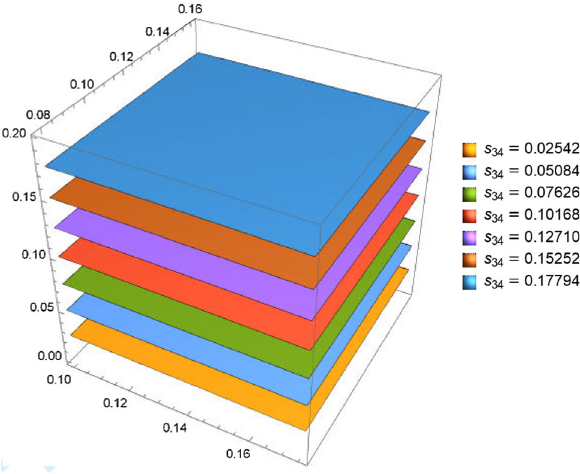
Fig. 4 | g u | versus s 14 and s 24 with s 14 ∈ ( 0 . 099 , 0 . 176 ) and s 24 ∈ ( 0 . 0782 , 0 . 163 )